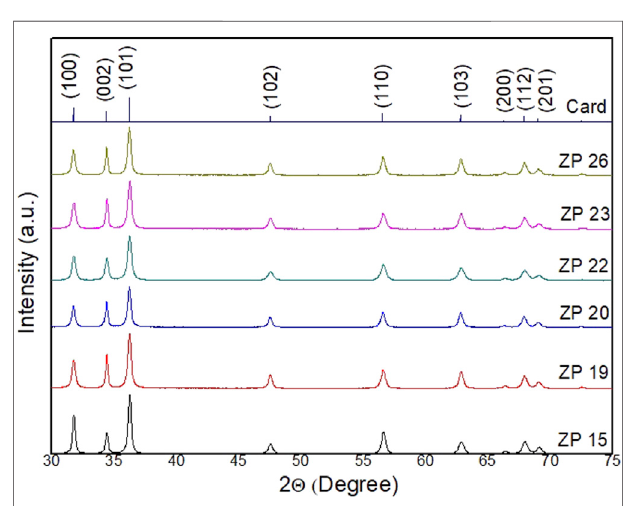
FIGURE 3 | XRD spectra of all synthesized ZnO